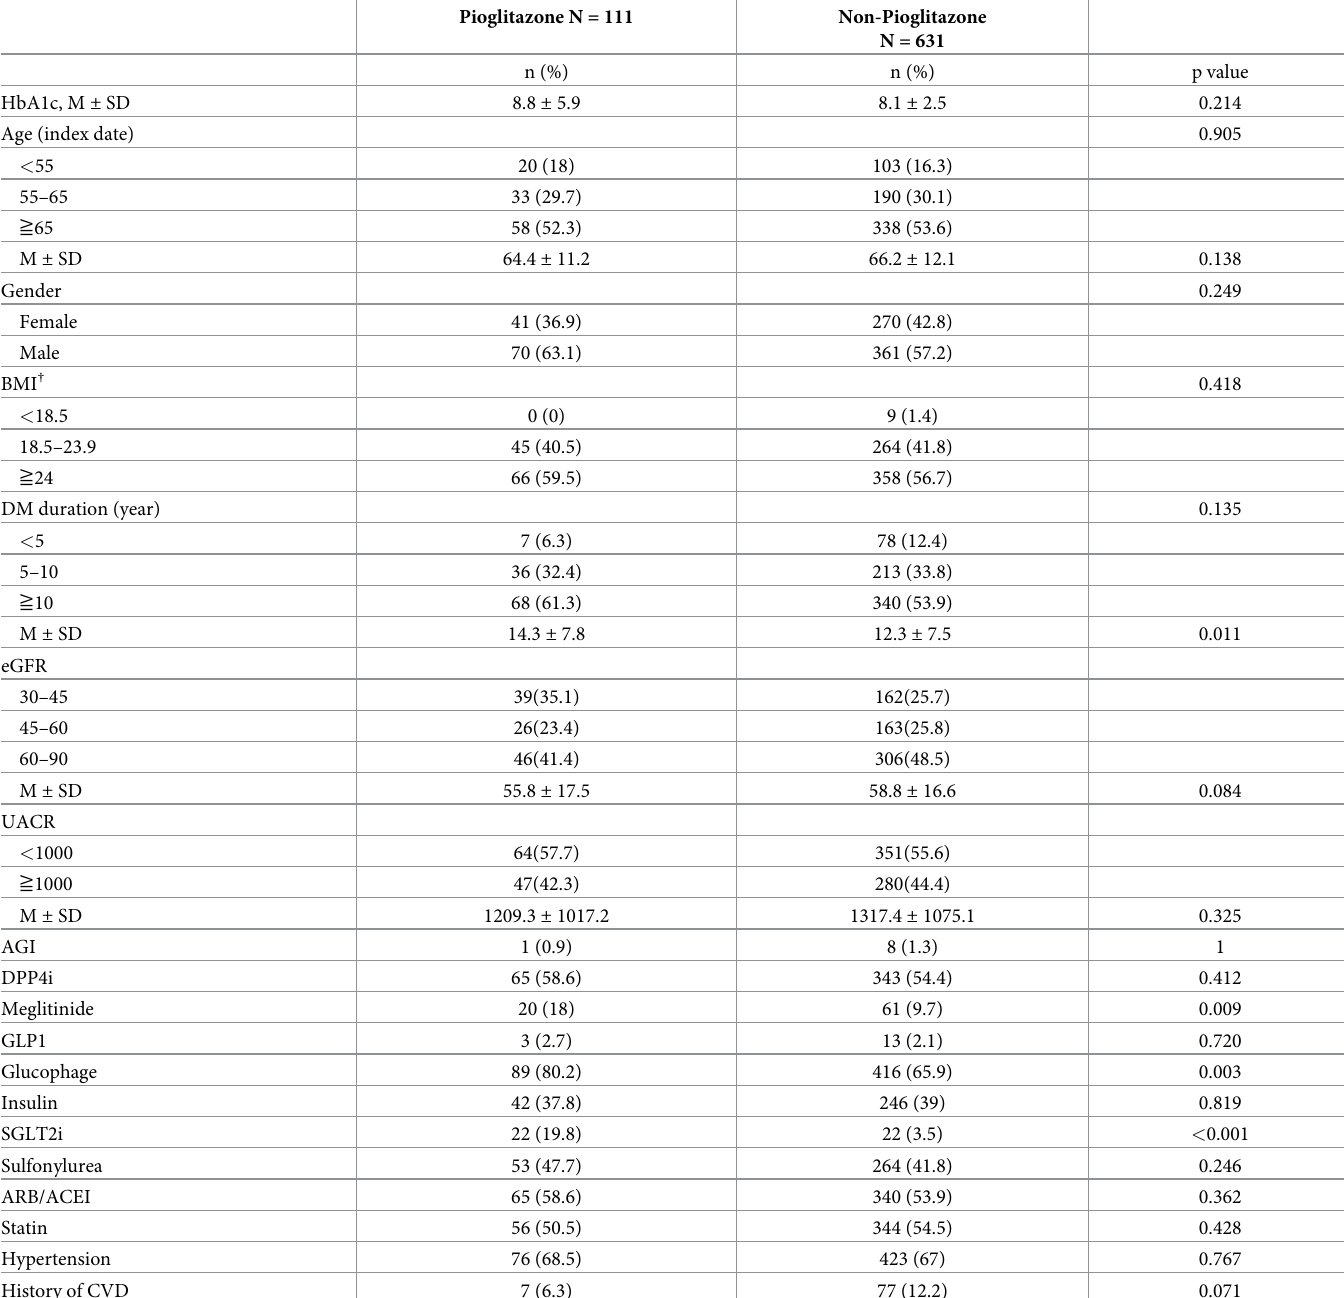
Table 1. Baseline demographic characteristics of